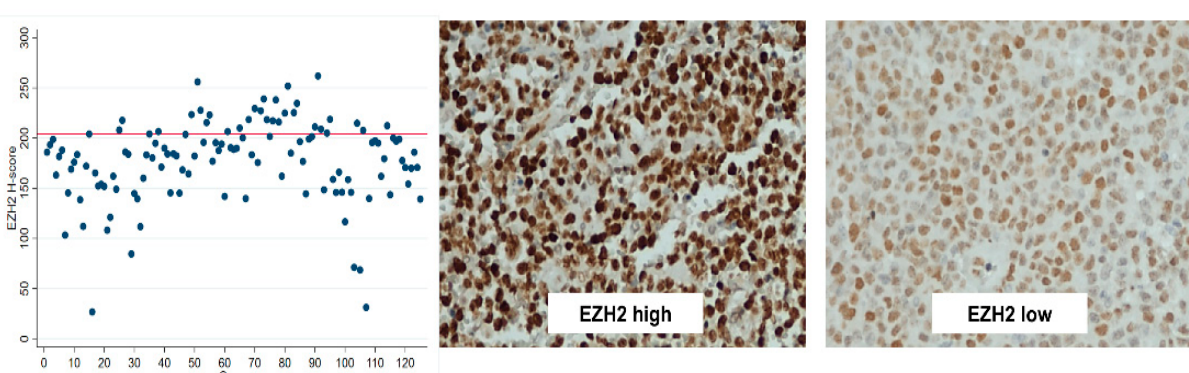
Figure 1. Distribution dotplot of EZH2 H-score ( n = 125) and illustrative cases of high versus low expression levels. Immunostaining was performed in TMAs, and IHC nuclear staining quantification was performed using a digital system (GenASIS™, Israel). Evaluation of intensity (score 0–3) and % of positive cells (0–100) was performed, allowing the calculation of an H-Score (0–300). Expression level H-scores were dichotomized in high versus low expression using the 75th percentile (204) as cut-off point. The staining pattern for EZH2 was homogeneous within each case. In most cases, there was intermediate to strong staining in the majority of tumor cells. Thus, the use of a digital software proved invaluable to allow the detection of small differences, which may not have been apparent had the authors used an “eyeball” evaluation